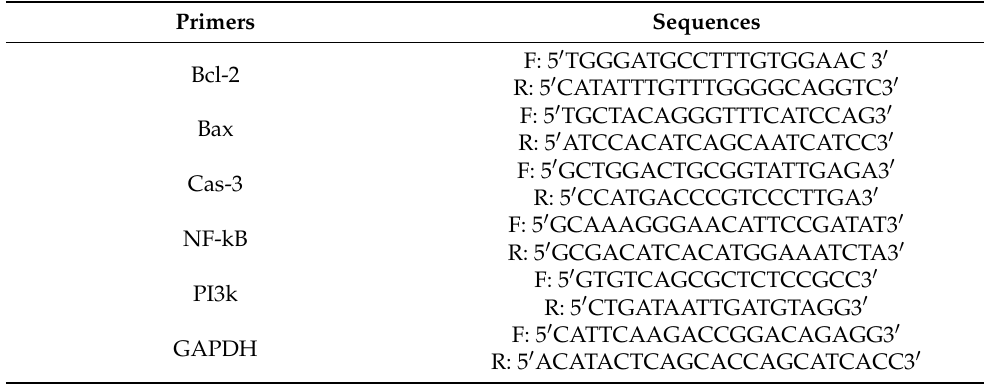
Table 1. Primer sequences used for